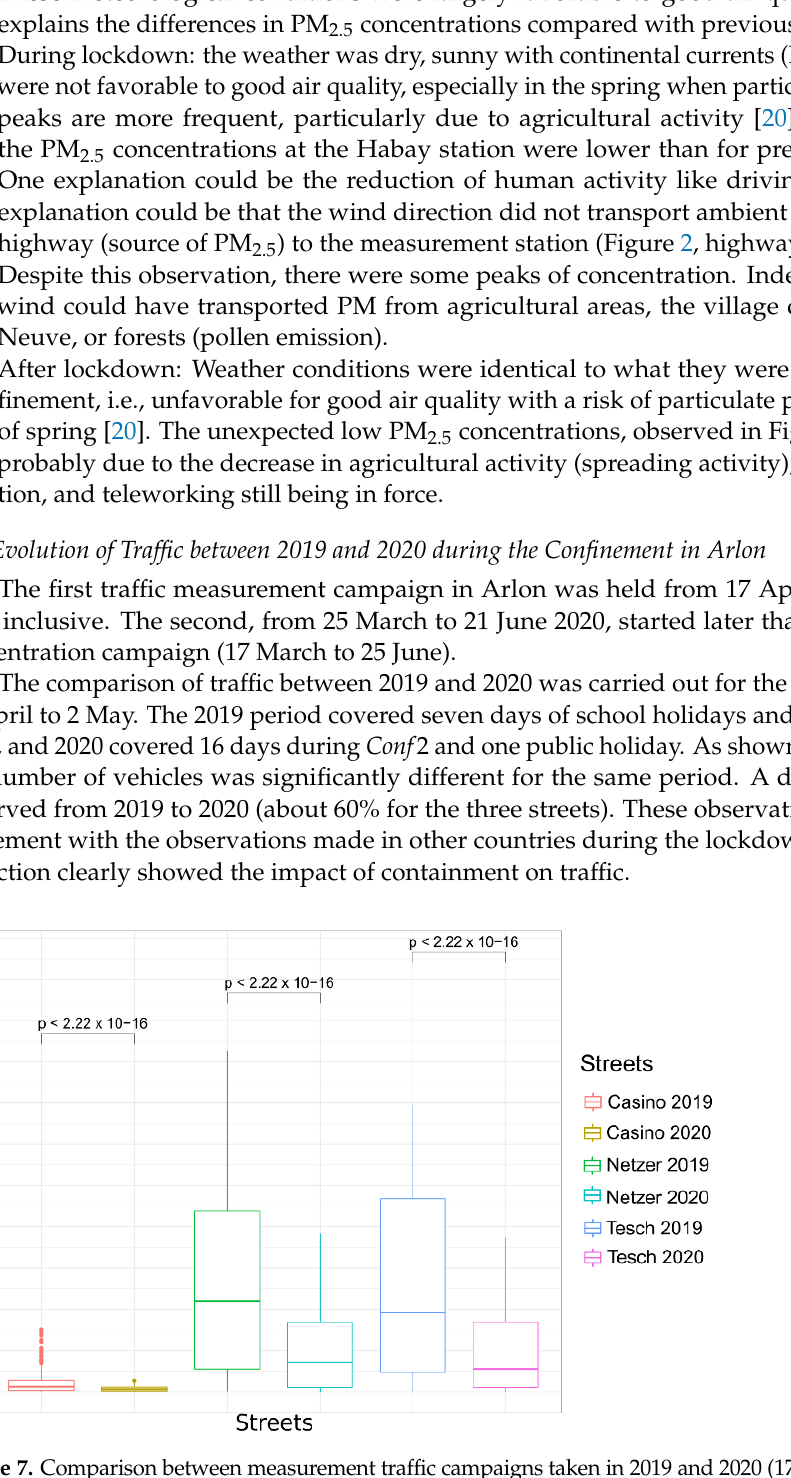
Figure 7. Comparison between measurement traffic campaigns taken in 2019 and 2020 (17 April – 2 May, inclusive); p – values were the results of Mann – Whitney Wilcoxon pairwise tests with the Holm correction ( α threshold =